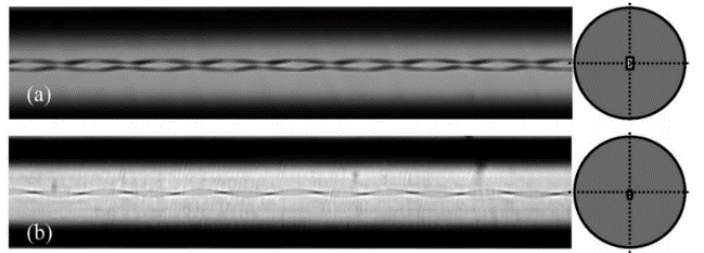
Figure 9. HLPGs with different helixes. ( a ) Double-helix HLPG produced by twisting a special fiber with concentric rectangular core. ( b ) Single-helix HLPG produced by twisting a fiber with off-center core. © [2021] IEEE. Reprinted, with permission, from Ref. [8].